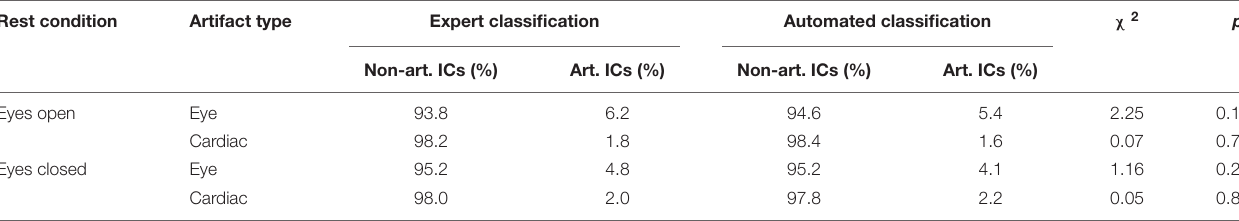
TABLE 1 | Comparison of the outcome of the two IC classification approaches. Rest condition Artifact type Expert classification Automated classification